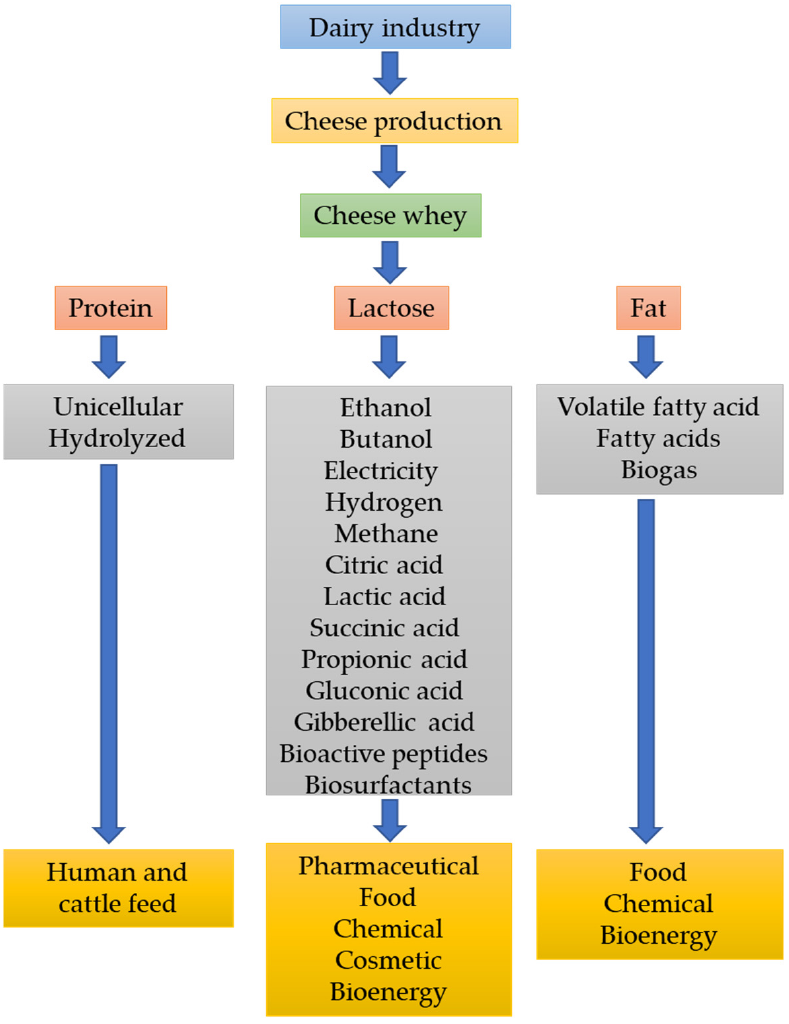
Figure 1. Biorefinery concept of cheese whey.